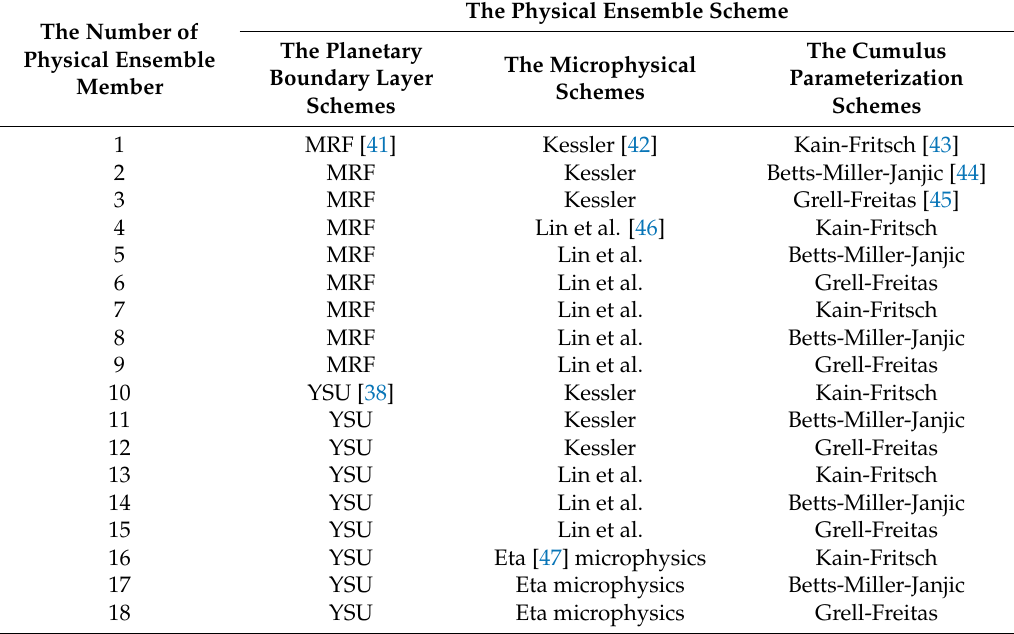
Table 2. Physical ensemble forecast schemes.